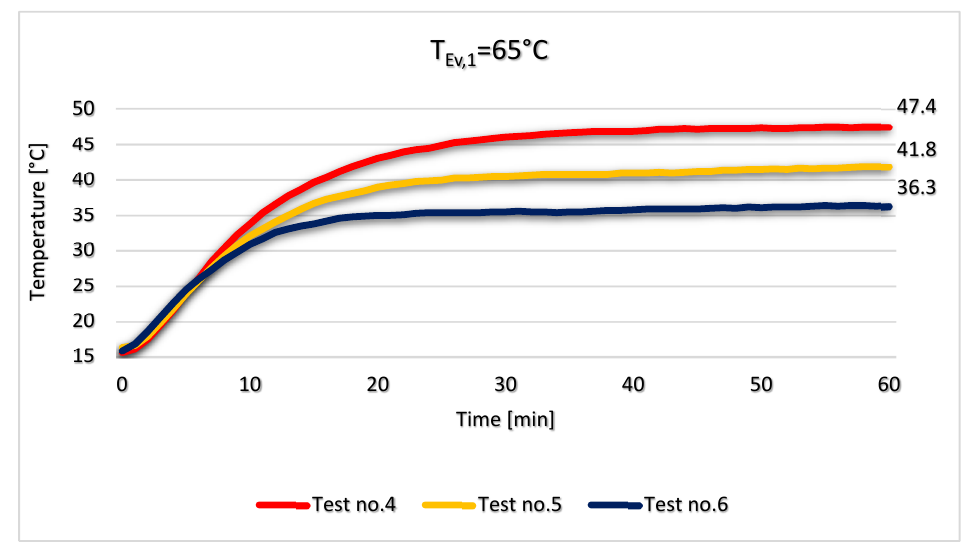
have a significant impact on the heat recovery rate. After about 20 min, the temperature rise in the condenser is slow, with about 0.1 °C/min for all of the three cases (Figure 6).